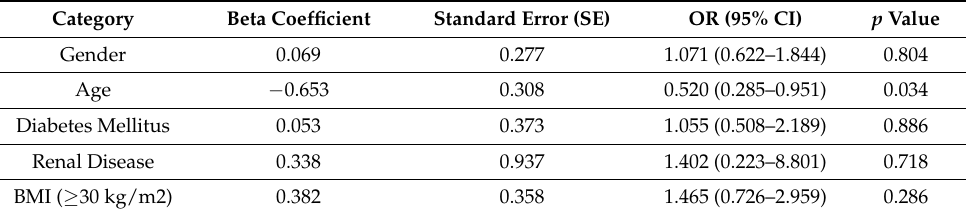
Table 4. Binary logistic regression analysis of putative factors associated with serum 25(OH)D concentration <30